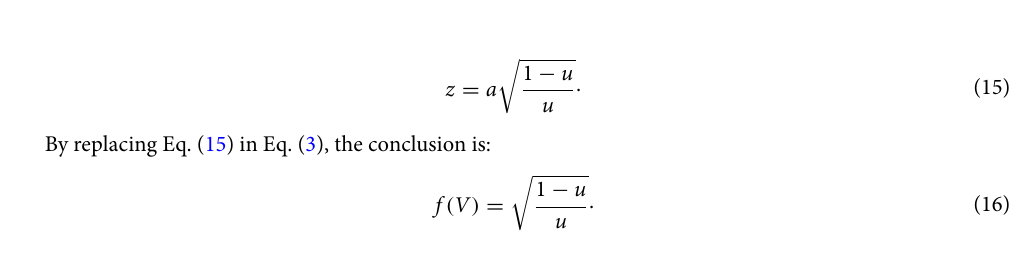
Figure 5. ( a ) Lorentz potential field to model donor acceptor interaction. ( b ) Rosen–Morse potential field to model molecular vibrations. ( c ) Coulomb-like square root potential field to model the electron confinement in